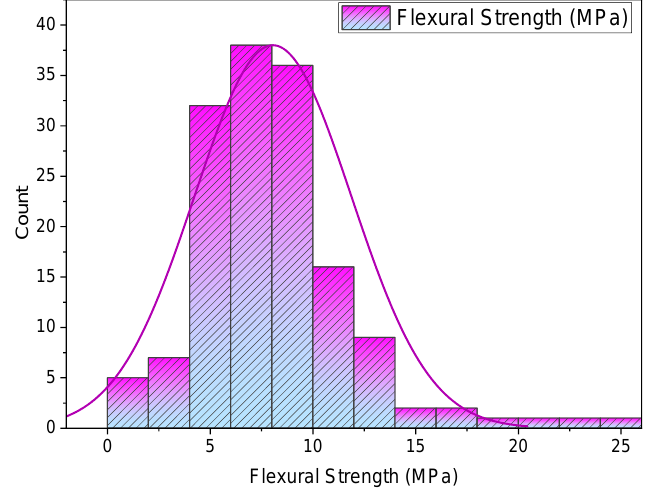
Figure 3. FS distribution.